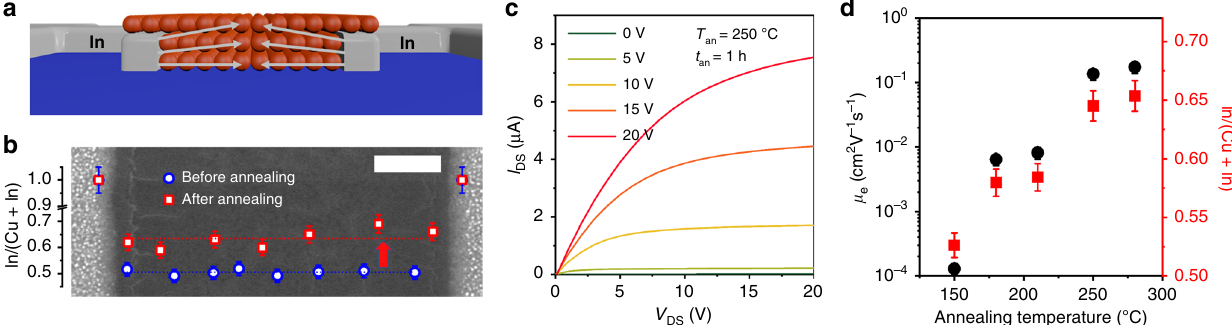
Fig. 2 CuInSe 2 CQD-based n -channel FETs. a n -channel FETs are realized by thermally annealing devices with indium source and drain contacts. During the annealing procedure indium diffuses into the CQDs wherein it acts as an n -dopant. b A top-view scanning electron microscopy (SEM) image (scale bar is 20 μ m) of the In-contact CuInSe 2 QD-FET together with the plot of the In/(Cu + In) ratio, determined by energy-dispersive X-ray spectroscopy (EDS), as a function of location along the channel before (blue circles) and after (red square) heat treatment at T an = 250 °C for t an = 1h ( T an and t an are the annealing temperature and time duration, respectively). c The I DS − V DS characteristics of the In-contact QD-FET made of iodide-capped CuInSe 2 CQDs and annealed at 250 °C for 1 h; the values of applied V GS are indicated in the legend. d The electron mobility (black circles) and the In/(In + Cu) ratio (red squares) of the n -channel In-contact FET made of CQDs treated with NH t = 1 h). Error bars in ( b ) and ( d ) 4 I as a function of annealing temperature (annealing time an represent standard deviations determined from the measurements of three nominally identical devices. Source data are provided as a Source Data fi